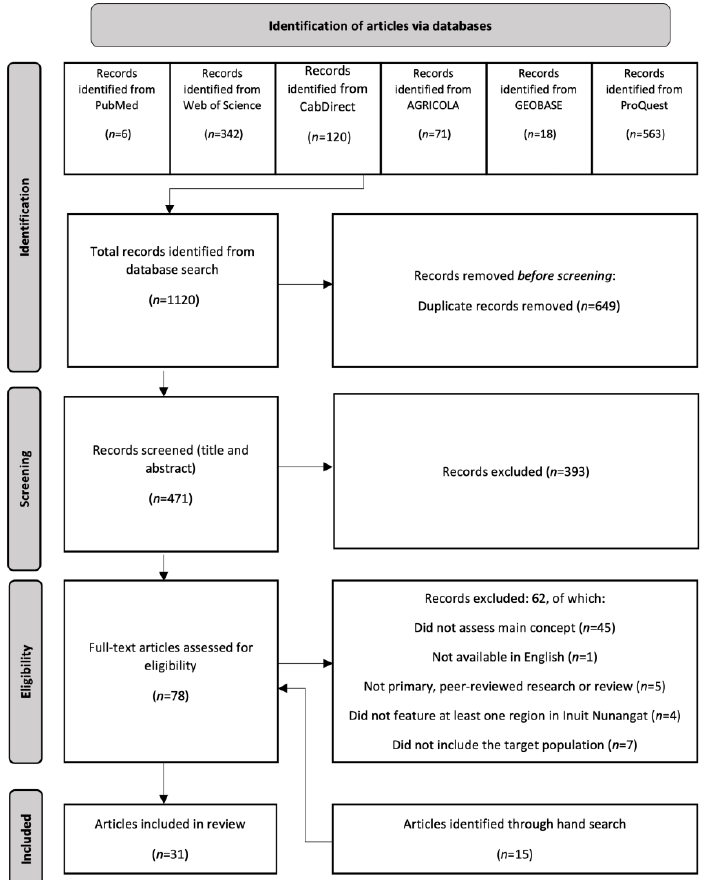
Figure 1. PRISMA flow diagram for identifying articles on the role of fisheries in food security in Inuit Nunangat.